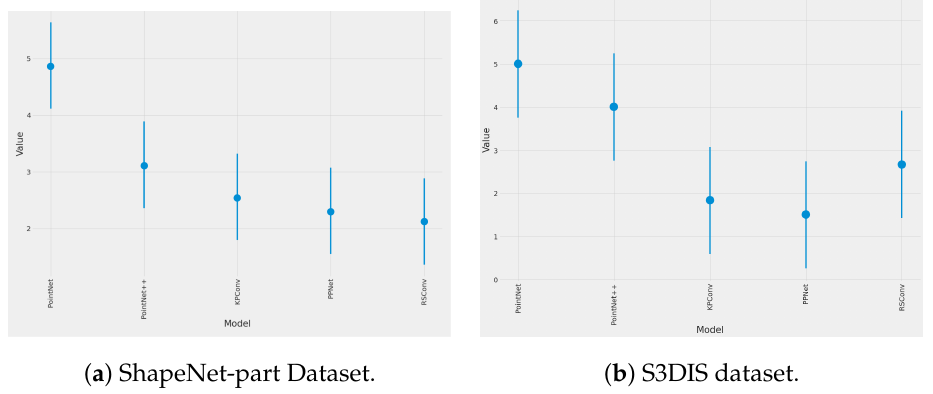
Figure 5. Nemenyi comparison of deep learning models. The bullets in the bars represent the mean ranks of each model and the vertical lines show the critical difference in the statistical test. Figure ( a ) shows the results in the ShapeNet-part dataset and Figure ( b ) the results in